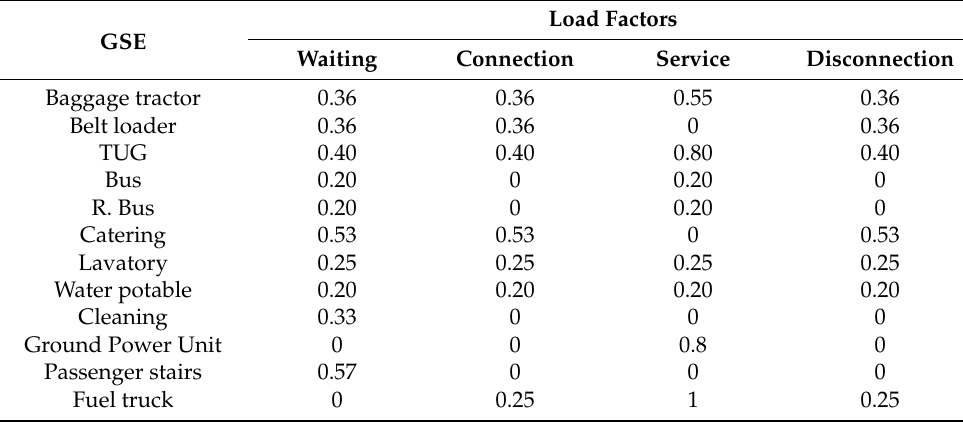
Table A2. Load factors according to loading times and operation.